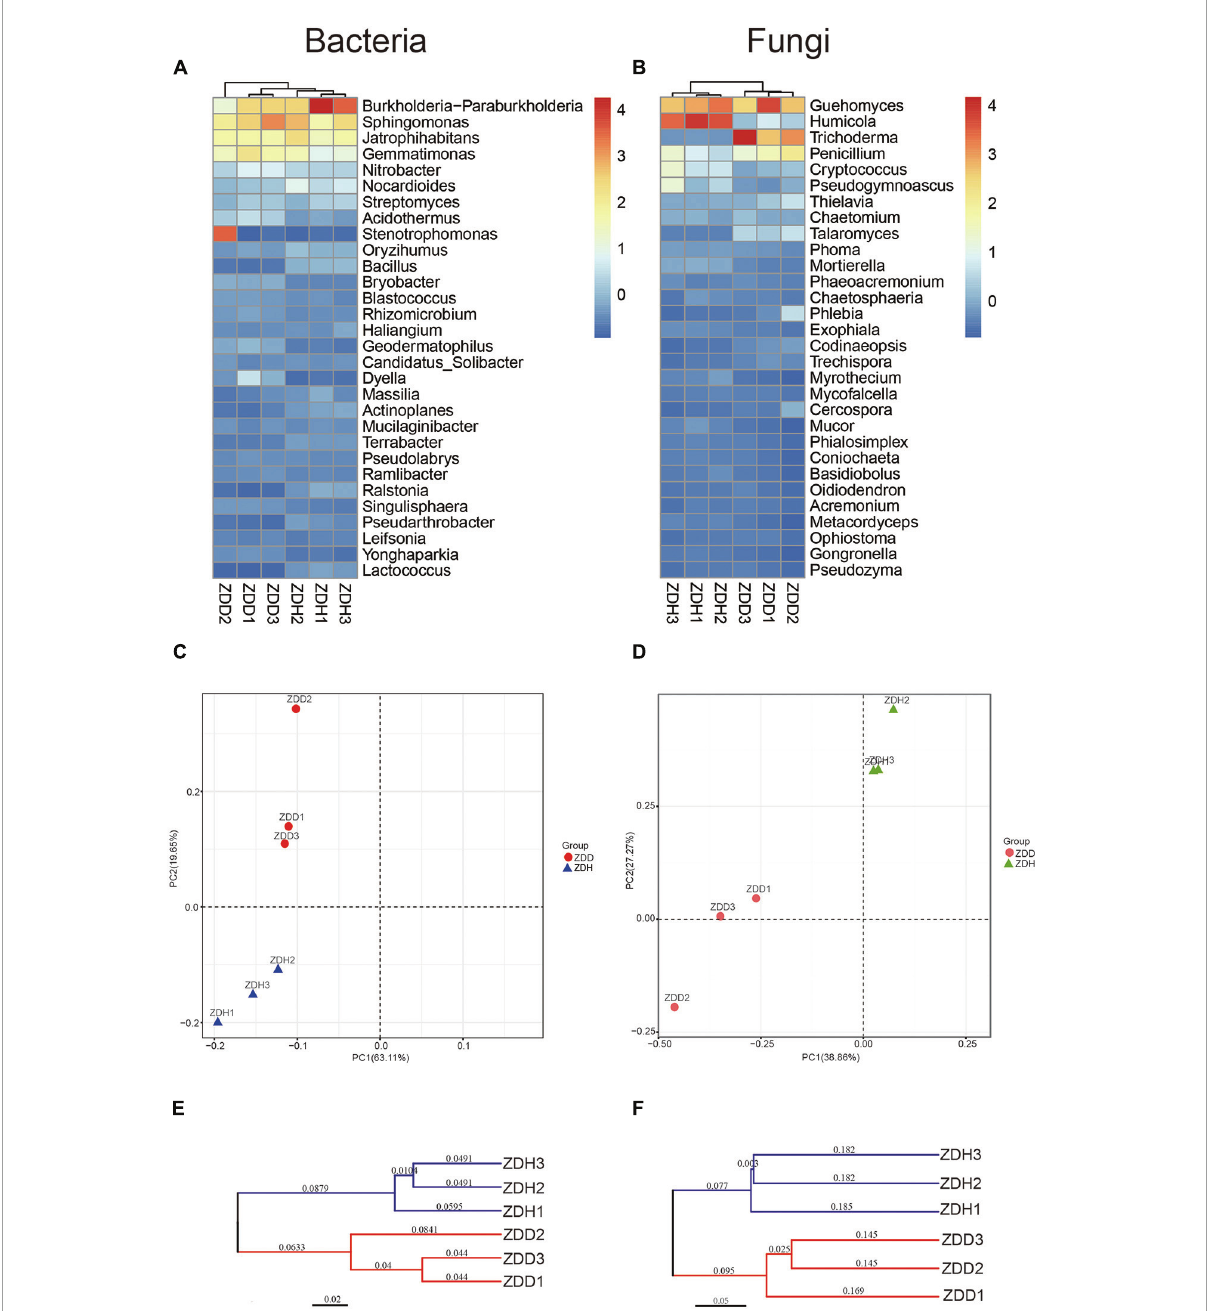
FIGURE3 Differences in bacterial (left panel) and fungal (right panel) community structure of different maize rhizosphere soil samples. Dendrogram and heatmap of soil bacteria (A) and fungi (B) communities for the top 30 abundant genera. Principal component analyses of soil bacteria (C) and fungi (D) communities. The cluster tree of soil bacteria (E) and fungi (F) communities from different rhizosphere soil samples on Bray-Curtis index. ZDD refers to rhizosphere soil with severe stalk rot disease, and ZDH refers to the rhizosphere soil with disease-free near by the